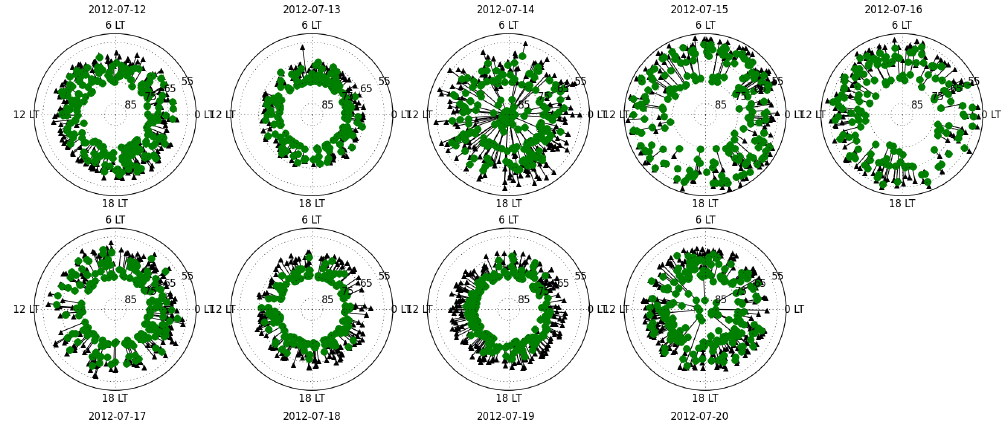
Figure 6. Green circles are auroral boundary locations (decimated) from the SSUSI sensor onboard DMSP satellite F18. The climatological boundary from IRI2012 is indicated as in Fig.